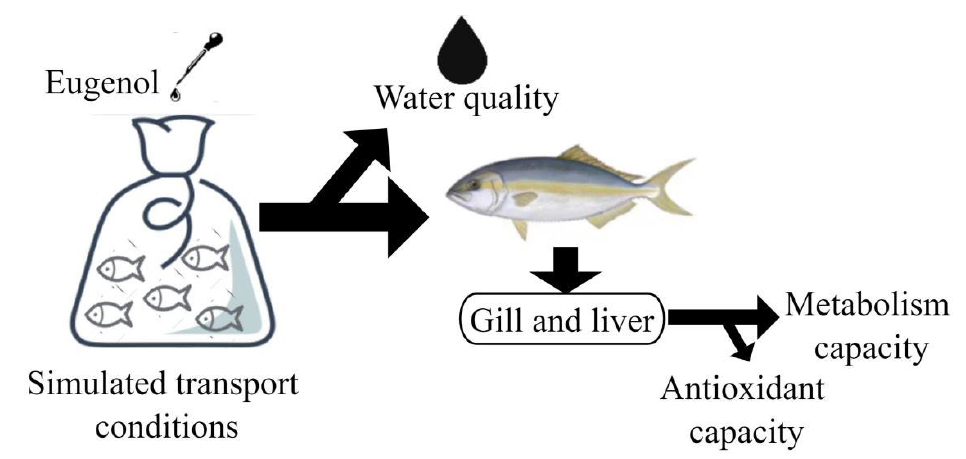
Figure 1. The schematic representation of the design and measured parameters for the simulated transport experiment.